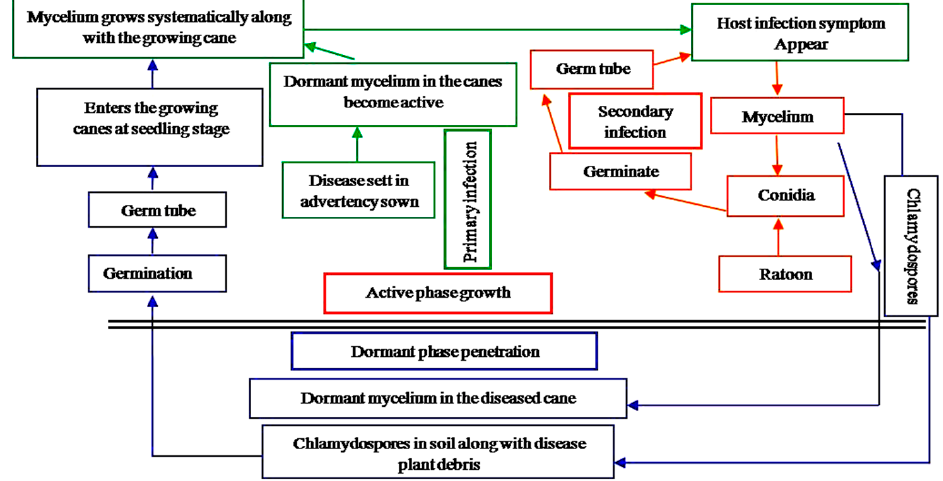
Figure 1. Life cycle of Colletotrichum falcatum Went in sugarcane plants. Green boxes indicate path of primary infection; orange boxes indicate secondary infection; blue boxes indicate dormant stage.